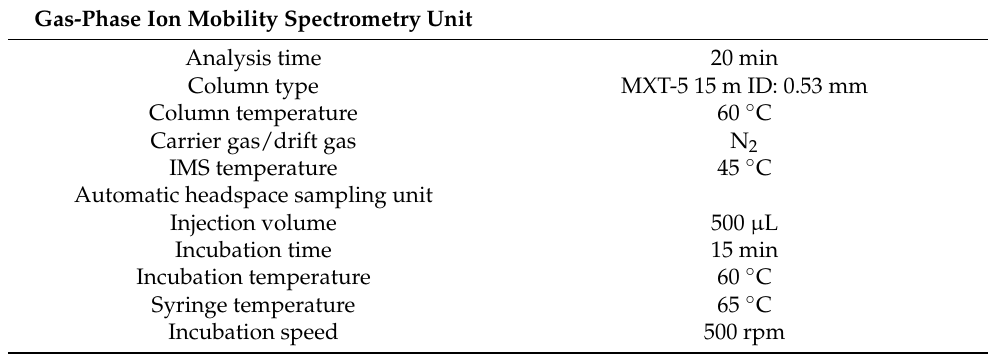
Table 2. Experimental conditions for Pingliang red beef analysis via